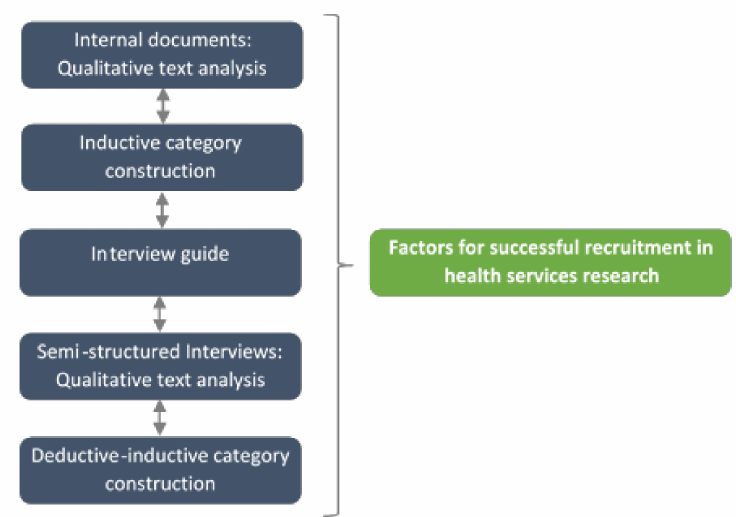
Figure 2. Iterative data collection and analytical